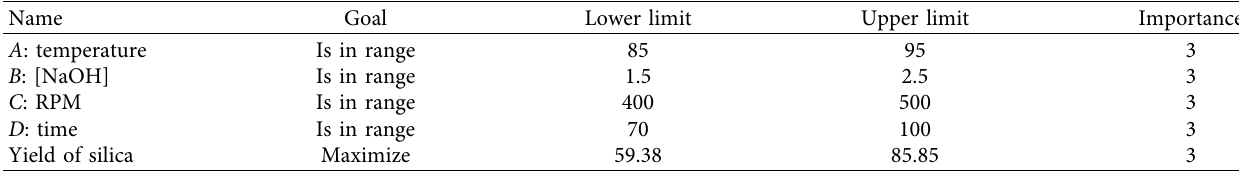
Table 6: Constraints.